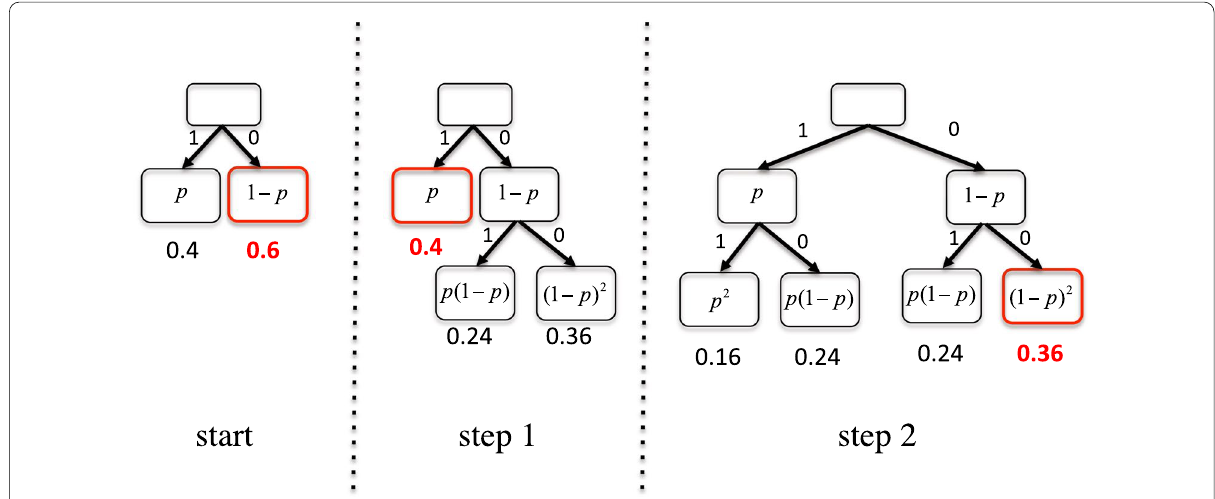
Fig. 8 Tunstall Tree for p = 0.4 . First two steps of the